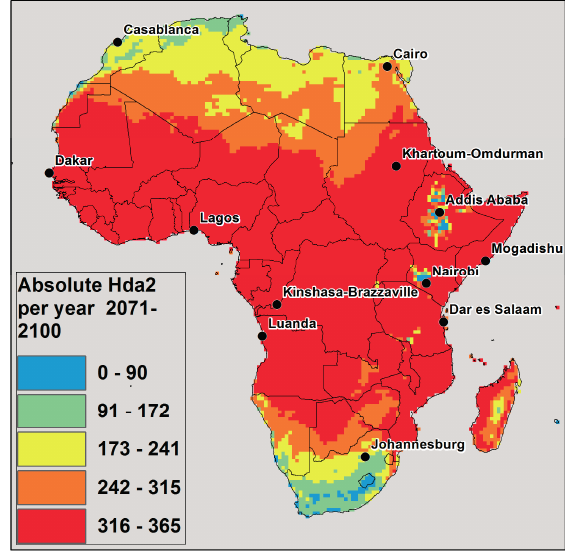
Figure 2. CCAM model outputs for number of Hda2 per year projected in